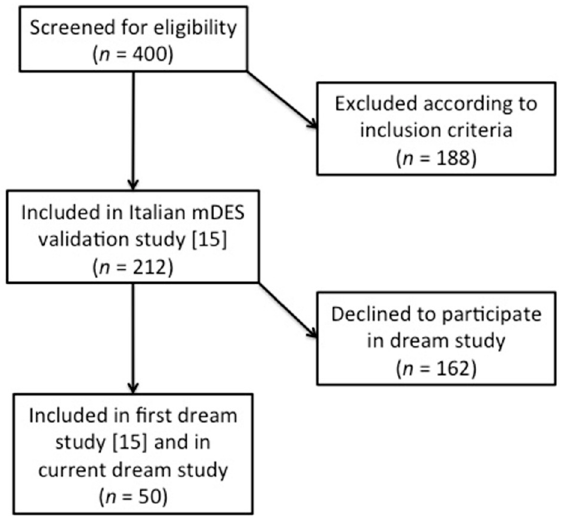
Figure 1. Flowchart of the participant recruitment and selection process.